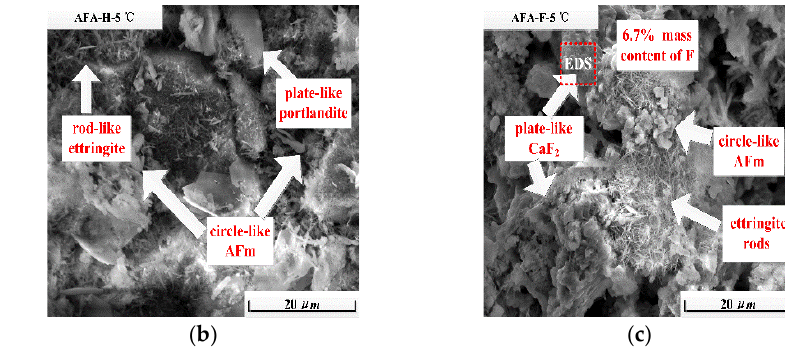
Figure 6. At 5 °C environment temperature, ESEM images of cement paste with reference one ( a ), alkali-free accelerators without fluoride ( b ), and with fluoride ( c ) at 24 h of hydration.